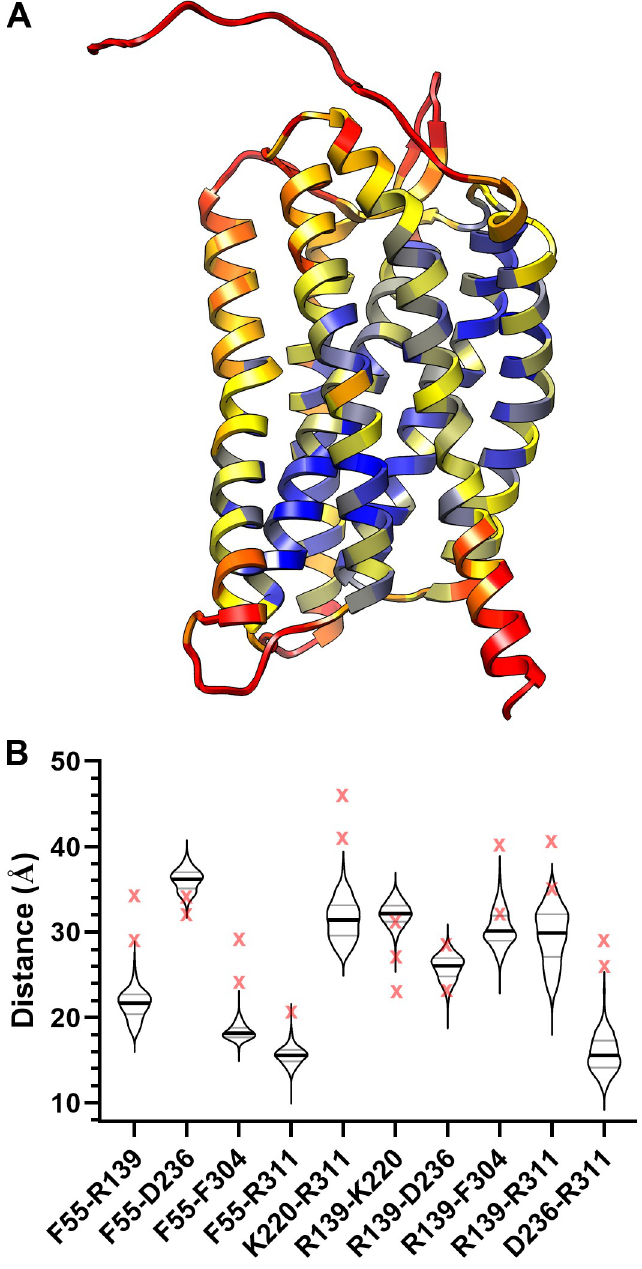
Fig 1. Apo-AT 1 R model. A , The apo-AT 1 R model with the movement of each residue color-coded based on the RMSF. The minimum observed RMSF (0.796 Å ) is blue, 25 th percentile (1.689 Å ) is yellow, median (2.272 Å ) is orange, and the 75 th percentile (3.165 Å ) and higher is red. B , A violin plot of the distances ( Å ) between the center of mass of the residues used in DEER spectroscopy [15] over the last 20 ns of simulation. The thick line represents the median and the thinner lines the 25 th and 75 th percentile. The red X represents the major modes from the DEER